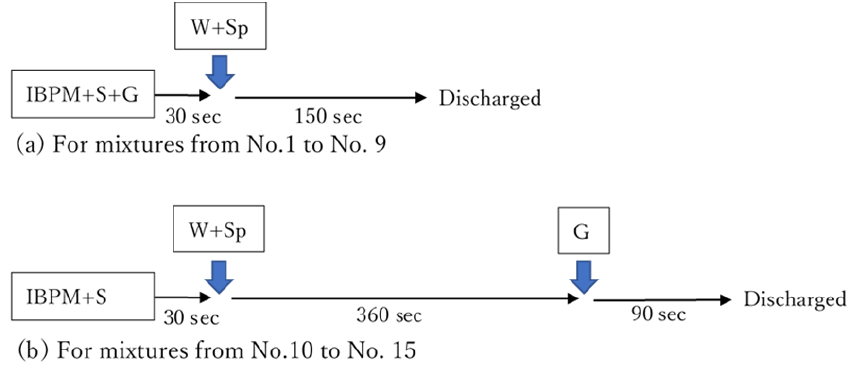
Figure 4. Mixing procedures for IBPM